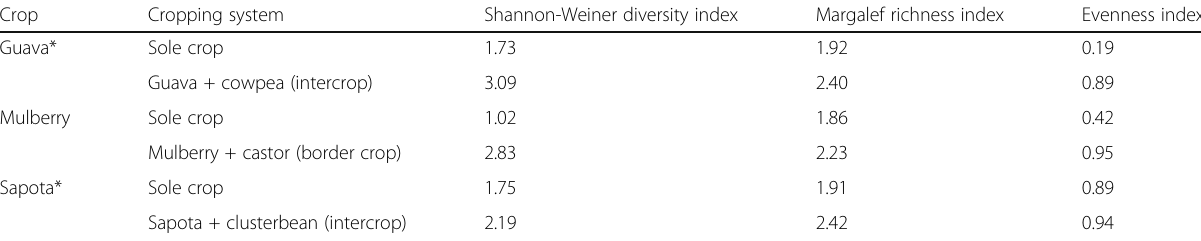
Table 2 Diversity indices of parasitoids and predators in sole cropped and intercropped, border cropped, and hedgerow cropped fields at Kanakapura district in Karnataka, India, during 2016 –